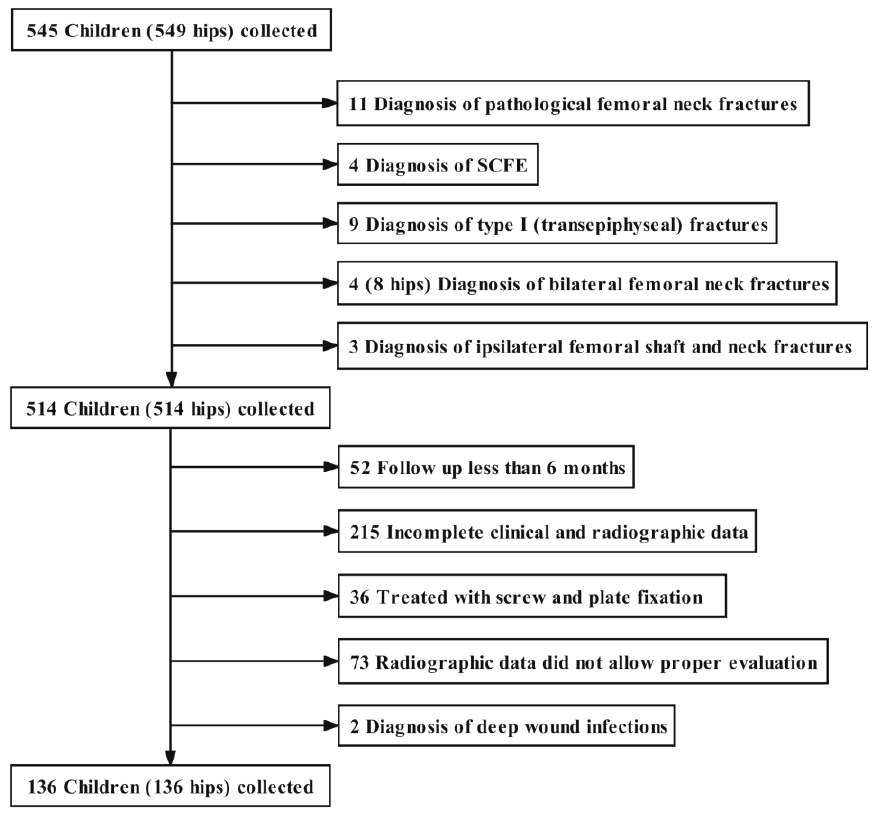
Figure 1. Study Figure 1. Study flowchart.